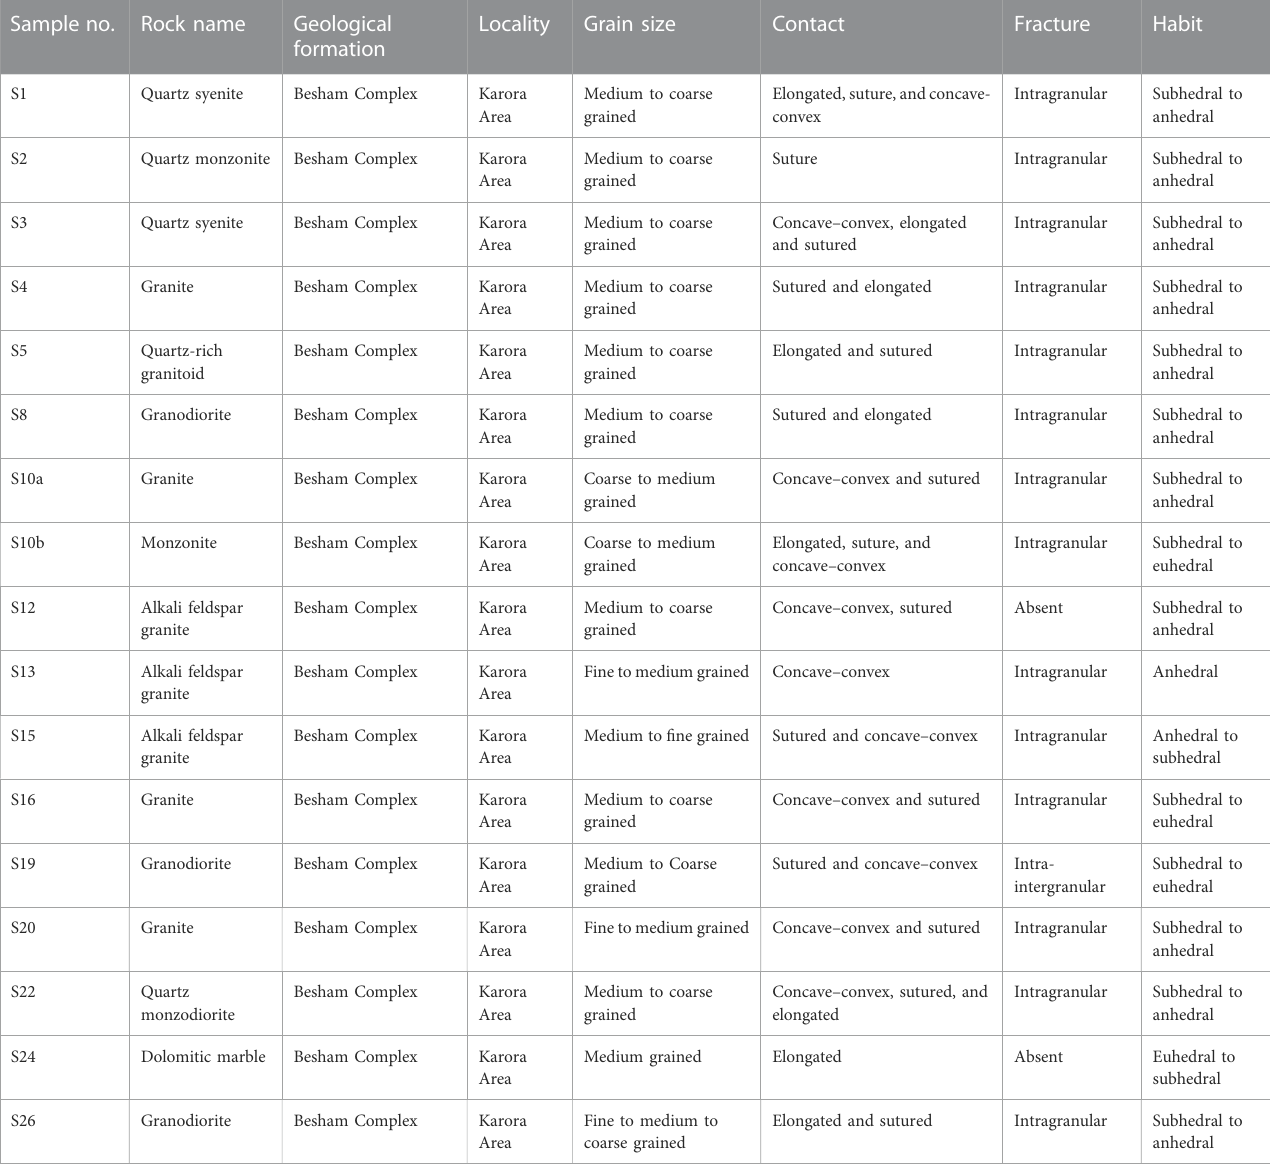
TABLE 5 Rock lithology, locality, and petrographic analysis of various minerals in the study area. Sample